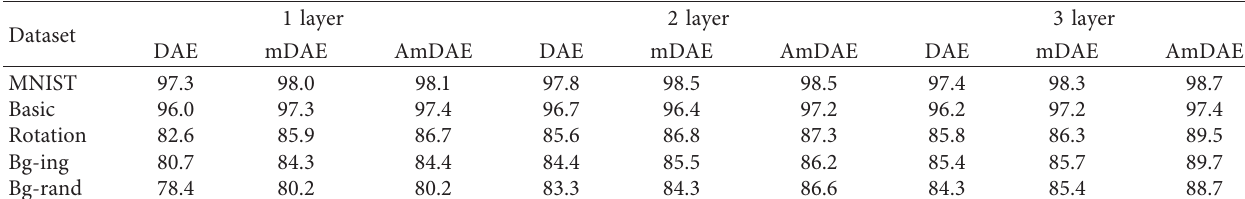
Table 3: Average recognition accuracy.